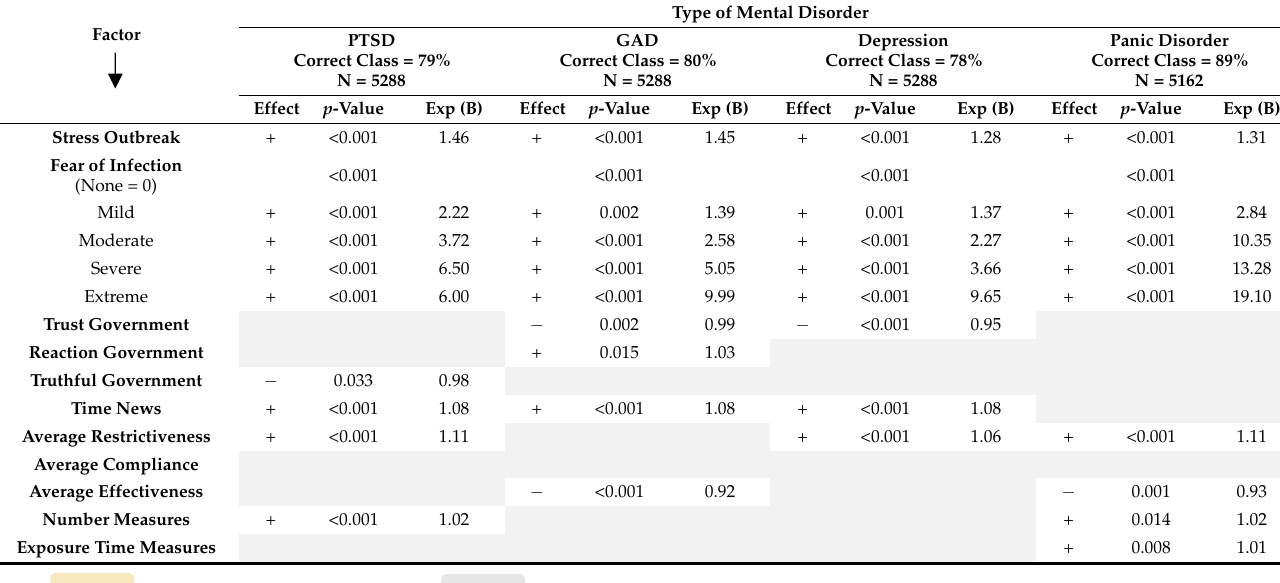
Table 1. Output from the multiple linear regressions with “Positive PTSD”, “Positive anxiety”, “Positive depression”, or “Positive panic disorder” as dependent variable and 25 independent factors . Table 1. Cont.